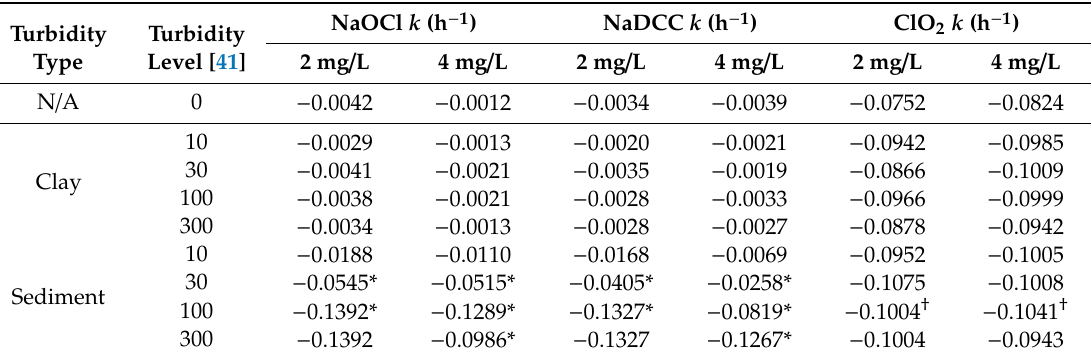
Table 2. First-order decay constants k (h − 1 ) for sodium hypochlorite (NaOCl), sodium dichloroisocyanurate (NaDCC), and chlorine dioxide (ClO 2 ) (based on duplicates grouped across three added total organic carbon (TOC) concentrations levels, n = 6 for each condition).